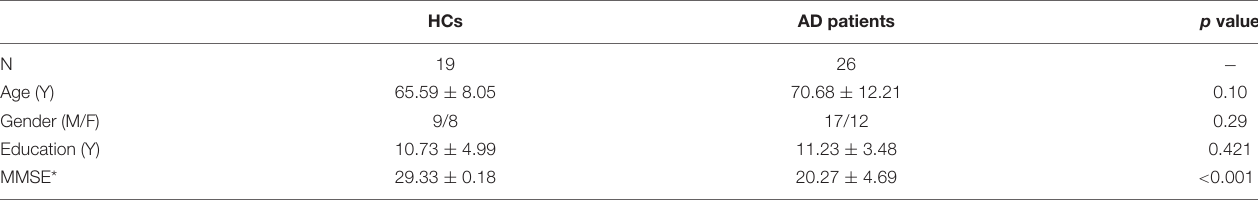
TABLE 1 | Clinical and demographic characteristics of all subjects. HCs AD patients